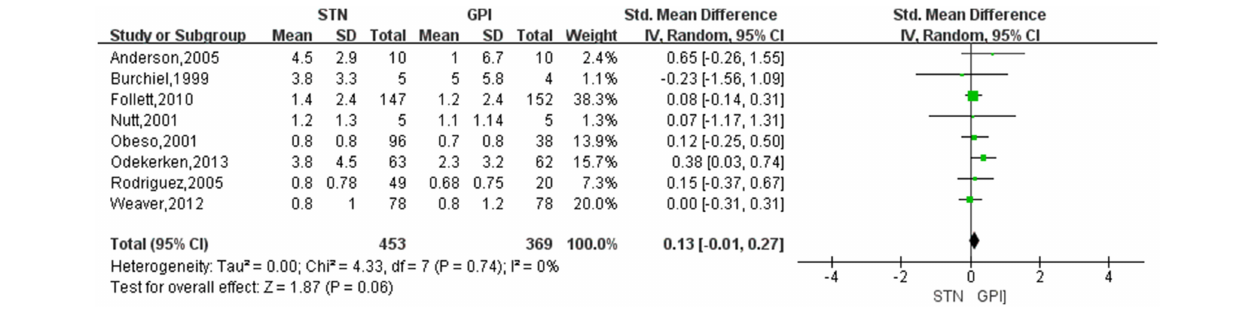
Frontiers in Neurology |